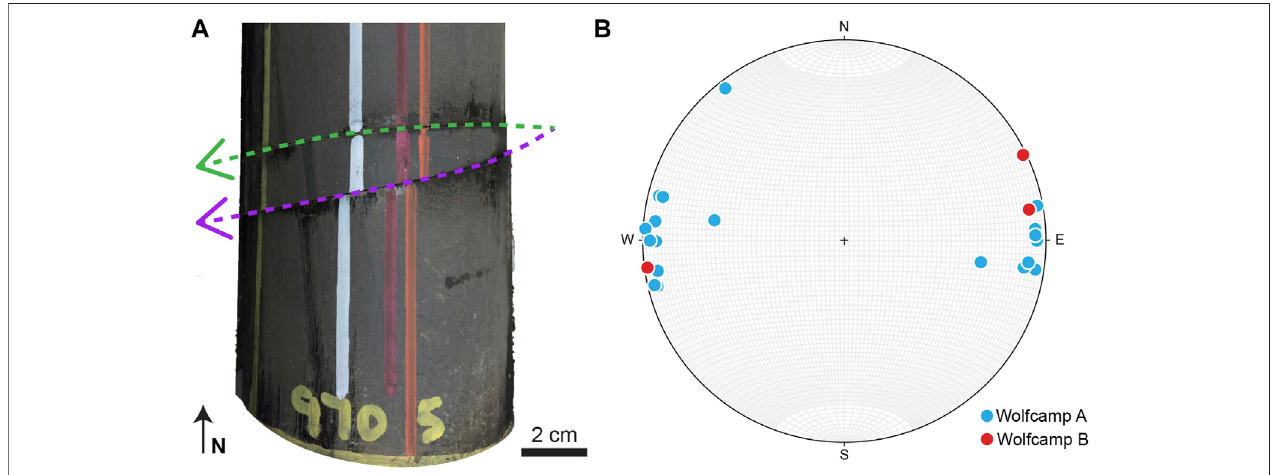
FIGURE 5 | (A) Photograph of core showing fracture doublet from the slant core, with the northern doublet fracture colored green, and the southern doublet fracture colored purple. The point of divergence is likely located just outside the eastern margin of the core. Direction of bifurcation is indicated with the yellow arrow. (B) Bifurcation directions for doublets in the Wolfcamp A and B plotted on a lower hemisphere stereonet.